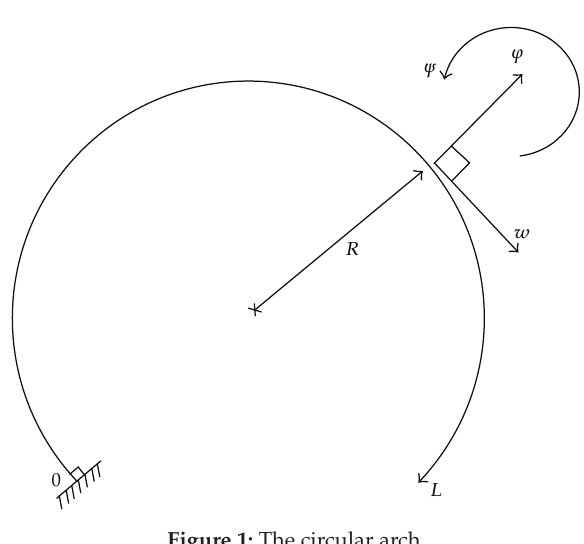
Figure 1: The circular